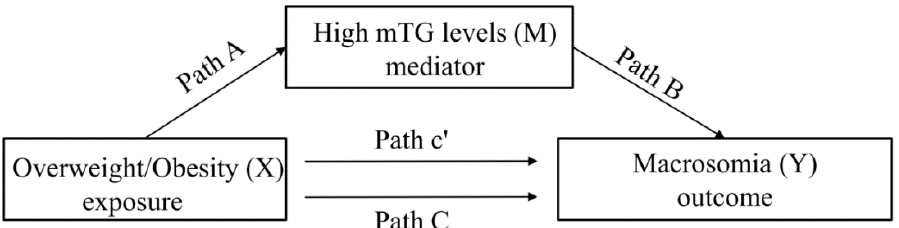
Figure 1. The illustration of the total (Path C), direct (Path c’), and indirect (Path A and B) effects of the association between the exposure (X) and outcome (Y) via the mediator (M). Abbreviation: mTG = maternal triglyceride.